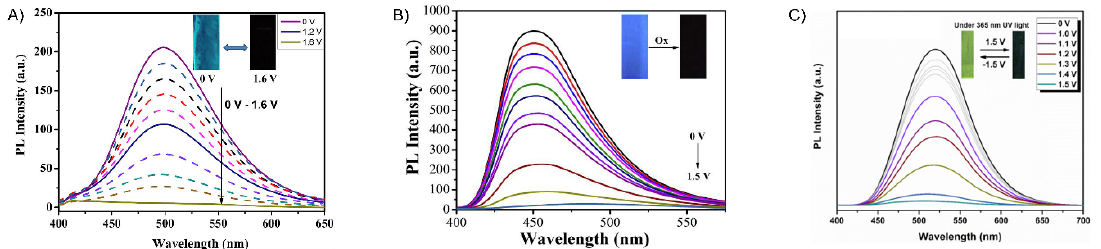
Figure 12. Electrofluorochromism of P1b ( A ) and P2a ( B ), and P3b ( C ) in a half-device configuration. Insets: photographs showing the fluorescence off/on with applied potential [135–137]. ( A ) Reproduced with permission from ref. [135]. Copyright 2019 Elsevier. ( B ) Reproduced with permission from ref. [136]. Copyright 2019 Elsevier. ( C ) Reproduced with permission from ref. [137]. Copyright 2019 Elsevier.